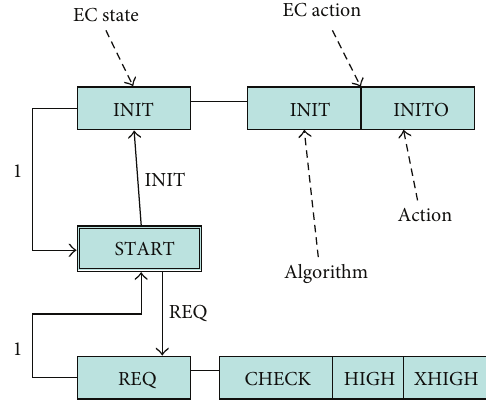
Figure 5: A simple execution control chart (ECC) to define the dynamic behaviour of FB